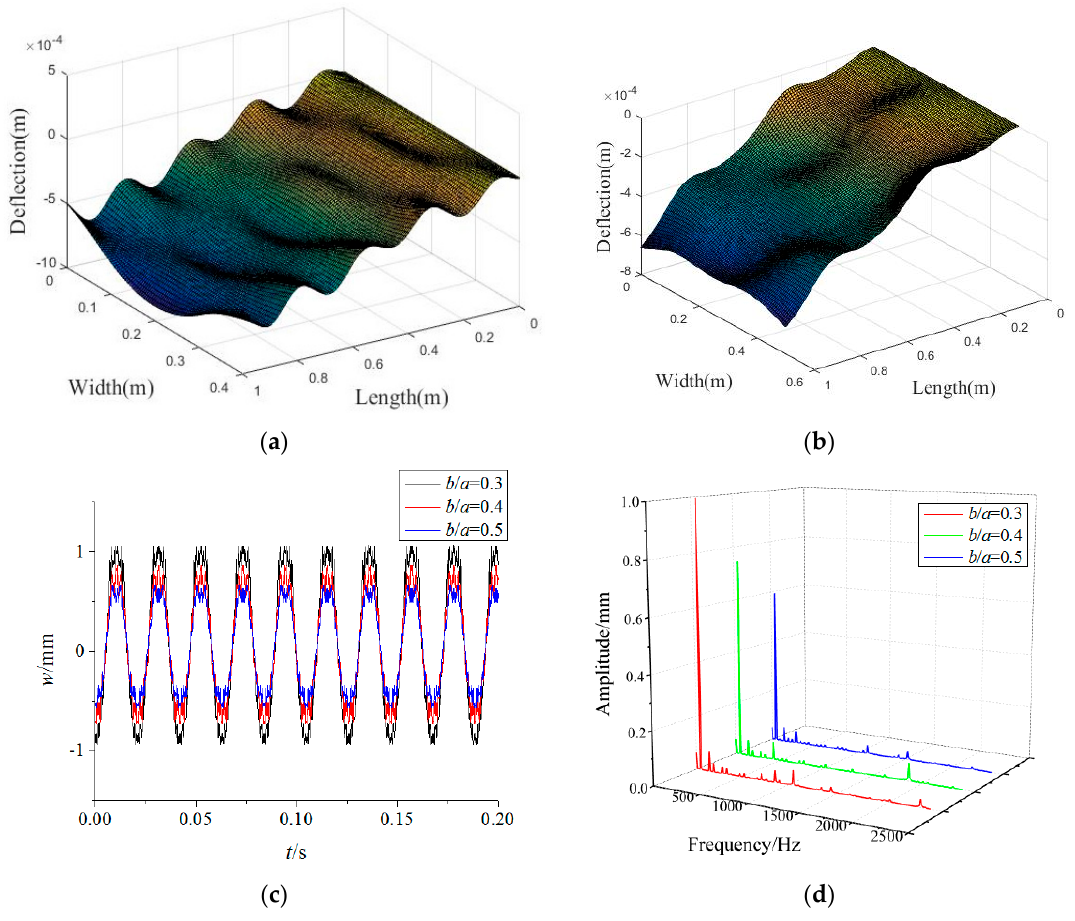
Figure 8. Effects of plate width-to-length ratios on forced vibration responses of the rotating FGM plate ( a ) b / a = 0.4, ( b ) b / a = 0.5, ( c ) time-domain response, ( d ) frequency-domain response.